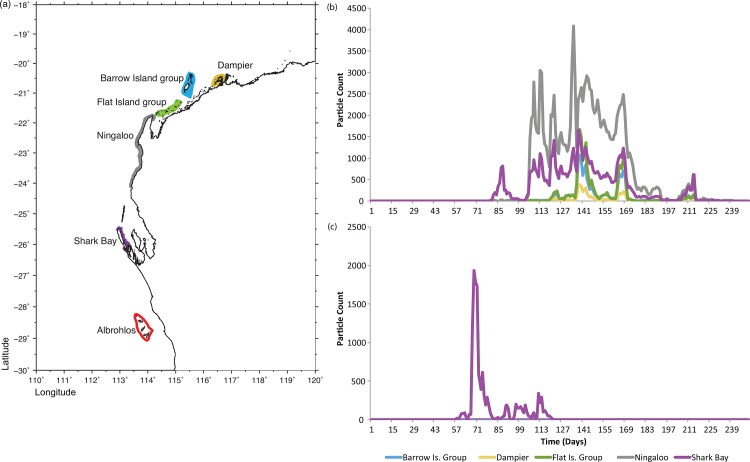
a) Location of potential northern seeding reefs and the HAI used in the dispersal modelling b) Simulated larval arrivals from the potential northern seeding reefs to the HAI in 2010 and in c) 2011.